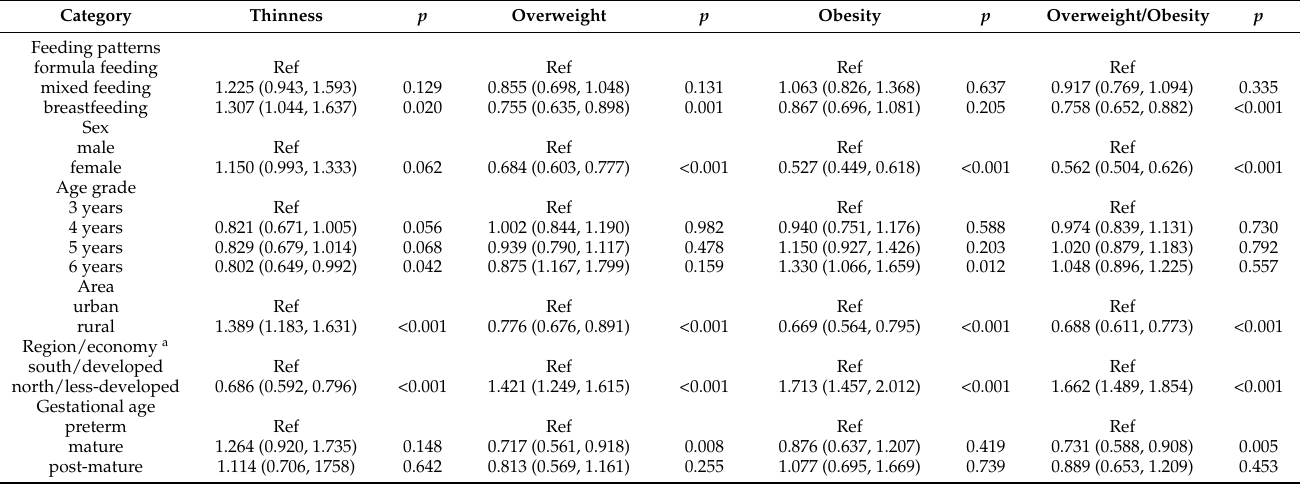
Table A1. Adjusted ORs (95% CI) of breastfeeding and covariates for thinness, overweight, and obesity in multivariate logistic regression